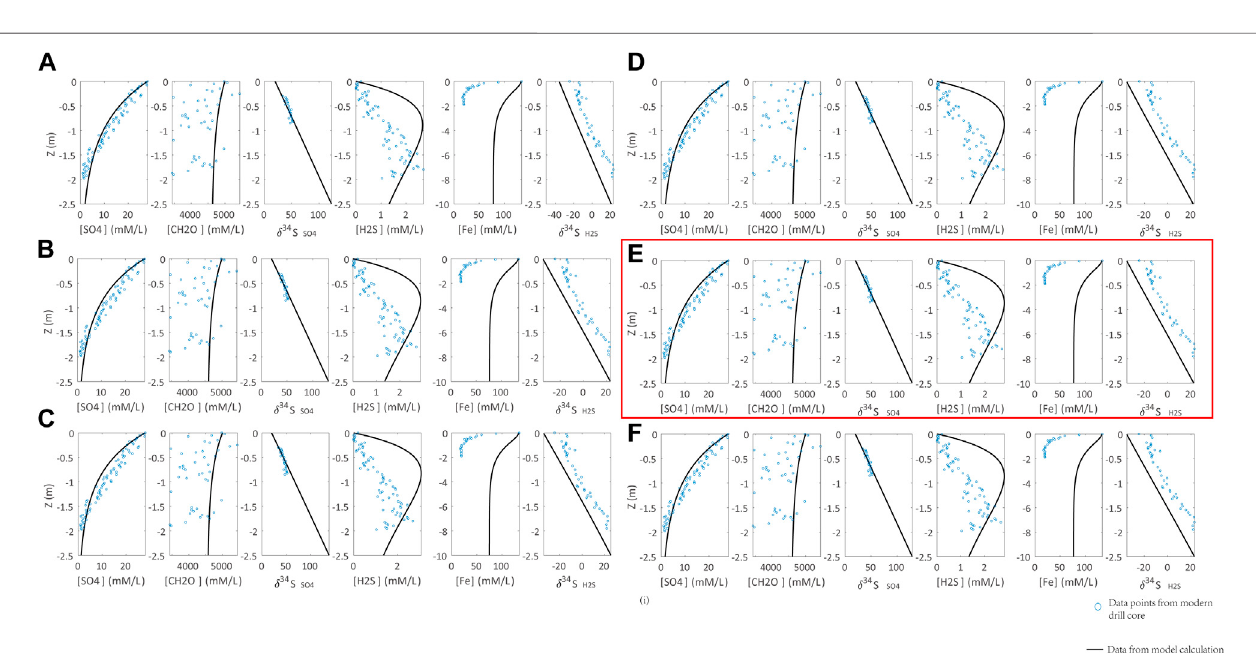
FIGURE 3 | Calibration of the DSR reaction rate constant (R DSR ) with observations from modern marine sediments (Soutar and Crill, 1977; Raven et al., 2016). Parameters of calculations are R py (cid:1) 0.3 [(mM/L)*ka] − 1 , Δ DSR (cid:1) 70 ‰ . R DSR is set to (A) 0.003, (B) 0.0035, (C) 0.004, (D) 0.0032, (E) 0.0033, (F) 0.0034 [(mM/L)*ka] − 1 . Blue points are the modern marine sediment samples. The black lines represent the modeling results. R DSR (cid:1) 0.0033 [(mM/L)*ka] − 1 in (H) can simulate the sulfate pro fi le of modern marine sediments (highlighted by red box).